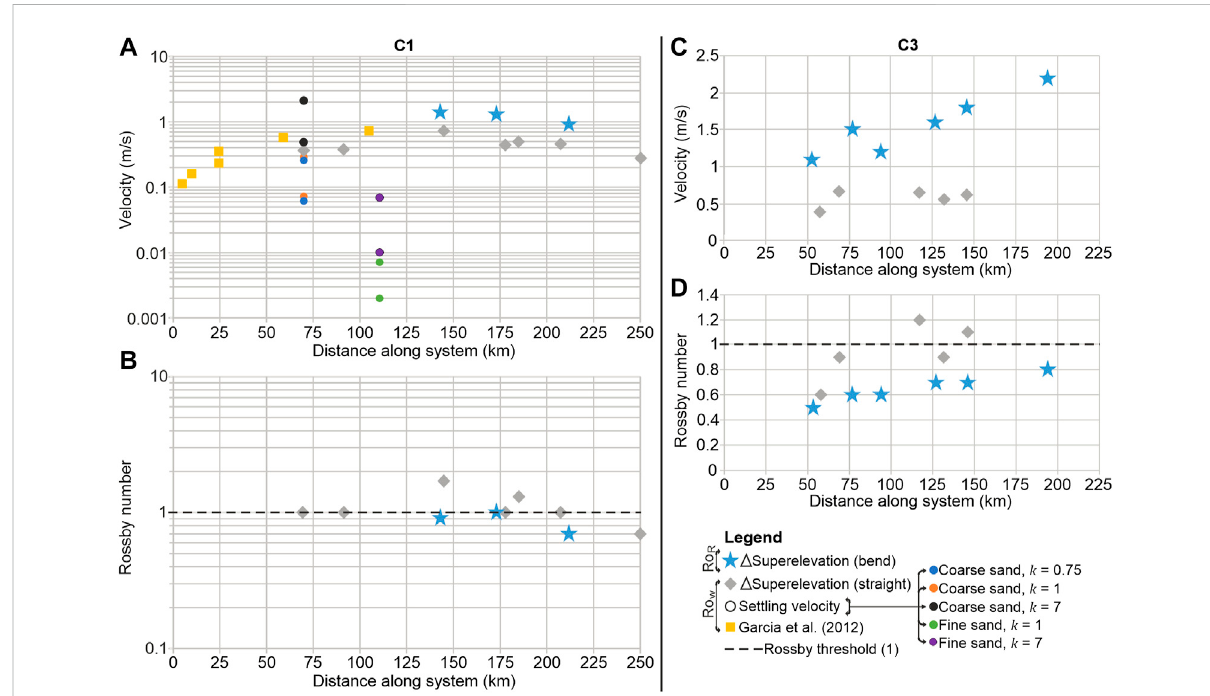
FIGURE 9 Comparison of estimated velocity values for C1 (A) and Rossby numbers calculated from these values (B) using the methodologies outlined in themaintext.VelocityvaluesarealsoestimatedforC3 (C) ,andRossbynumbersforthissystem (D) .OnlytwomethodologiesareusedforC3,asgrain sizedataforsettlingvelocityestimatesareunavailable,andGarcíaetal.(2012)onlygeneratedestimatesforC1.Calculationsusingthesuperelevation of the fl ow, based on levee height differences at bend apexes or straight sections, are depth-averaged approaches, with settling velocity a